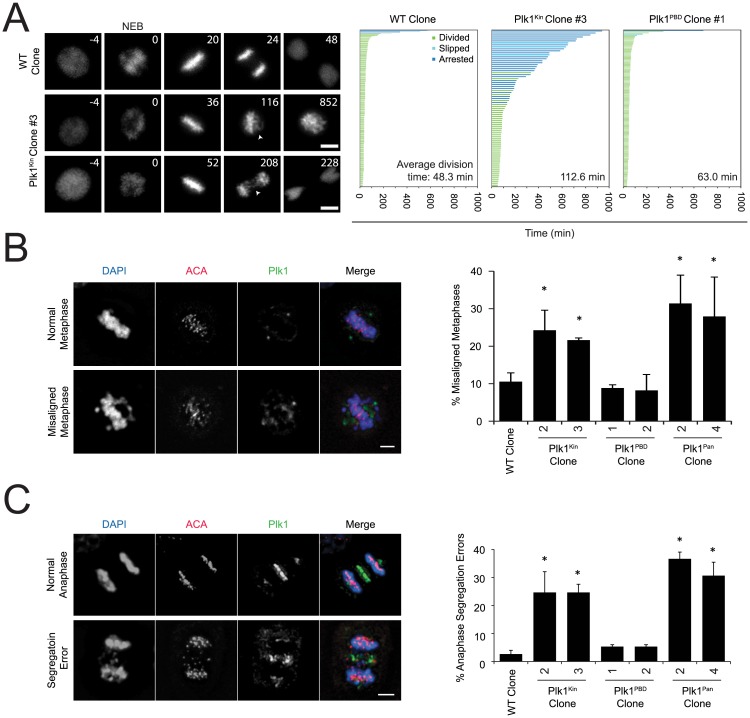
Plk1Kin is unable to rescue chromosome alignment or chromosome segregation.(A) Cells were infected with H2B-FusionRed lentivirus for 48 hours, treated with 3-MB-PP1, and placed on microscope in chamber containing 5% CO2 at 37°C. Images were taken every 4min with a 20X objective for 16+ hours. Duration of mitosis was quantified from mitotic entry to when daughter cells sat down. Still frames from time lapse showing representative cell fates for WT and Plk1Kin clones. Times indicate minutes from nuclear envelope breakdown (NEB). Arrows indicate examples of misaligned (middle row) and lagging chromosomes (bottom row). Scale bar, 5μm. Graph indicates individual cell fate and time in mitosis (≥ 79 cells in each condition). Average division time in lower right hand corner only includes cells that divided. Arrested (blue bars) indicates cells that did not divide during the movie. In this case, the data was censored and time in mitosis was quantified from mitotic entry to the end of the movie. Cells that began mitosis with <120min to the end of the movie and did not divide or left the screen were discarded. (B) Cells were treated with 3-MB-PP1 for 6 hours, fixed, and stained for Plk1 and ACA and with DAPI. n = 3, 63 or more metaphase cells were counted for each cell line for each replicate. *p<0.05 compared to incidence misaligned metaphases in WT Clone. Scale bar, 5μm. (C) Cells shown were treated with 3-MB-PP1 for 6 hours, fixed, and stained for DAPI, Antibody Against Centromere (ACA), and Plk1. n = 3, 60 or more anaphase cells were counted for each cell line for each replicate. *p<0.05 compared to incidence of anaphase segregation errors in WT Clone. Scale bar, 5μm.